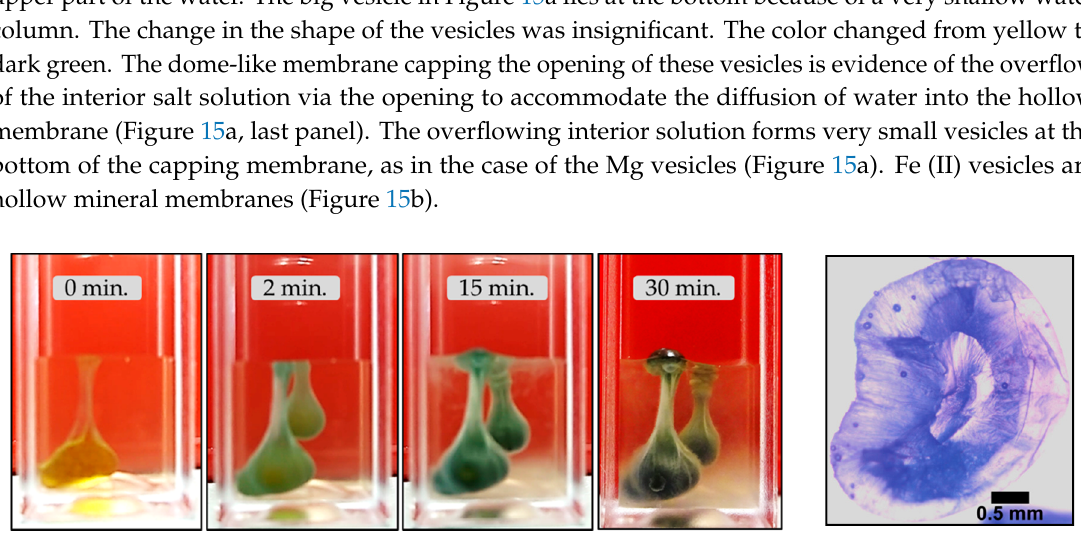
Figure 14. Zinc sulphate mineral vesicle: ( a ) lateral view; ( b ) hollow vesicle with its opening.